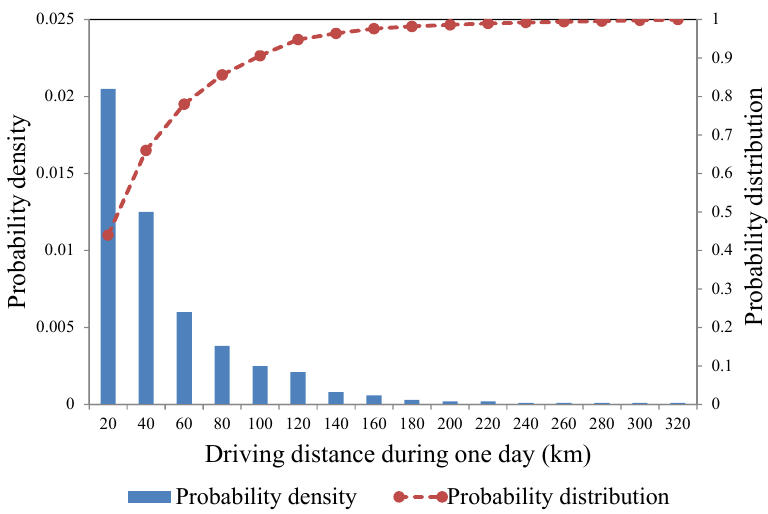
Figure 3. Driving pattern data: driving distance [26].